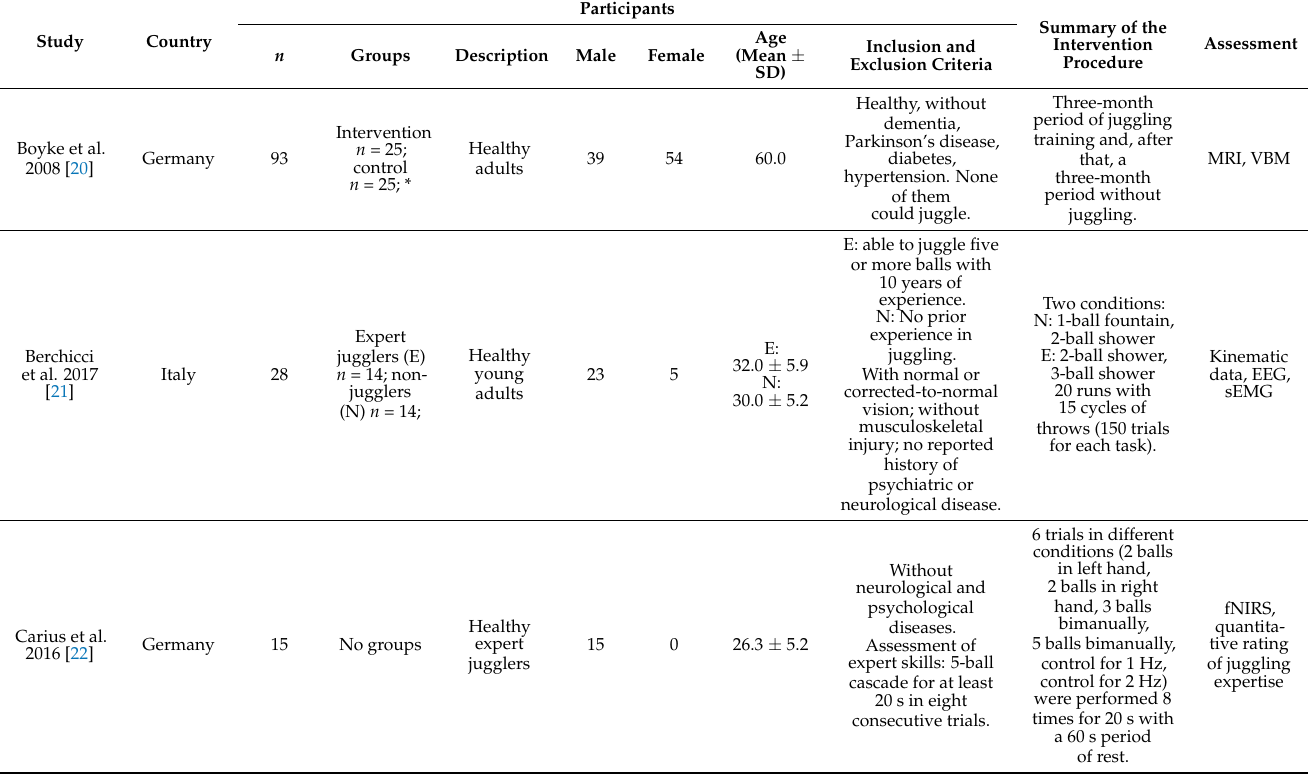
Table 1. Summary of participants and